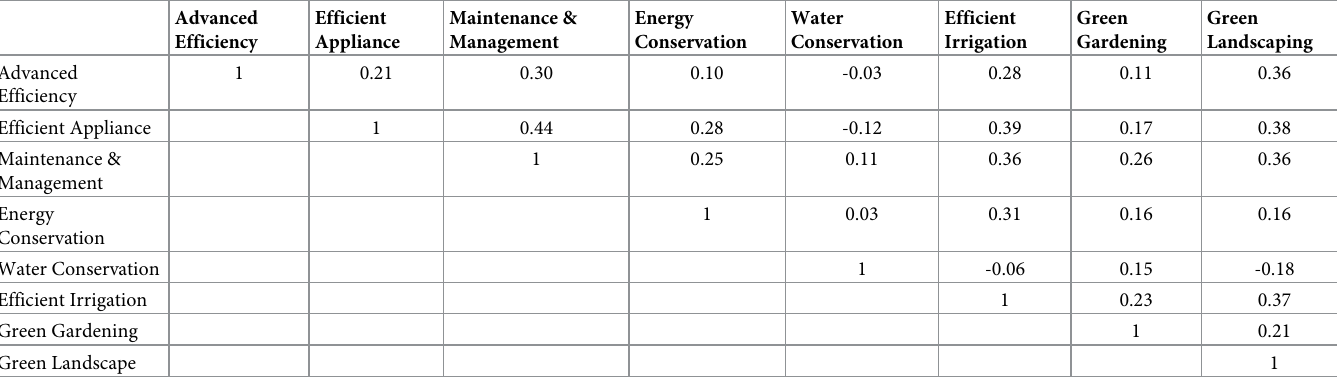
Table 5. Correlations among water-energy-saving measure classes.